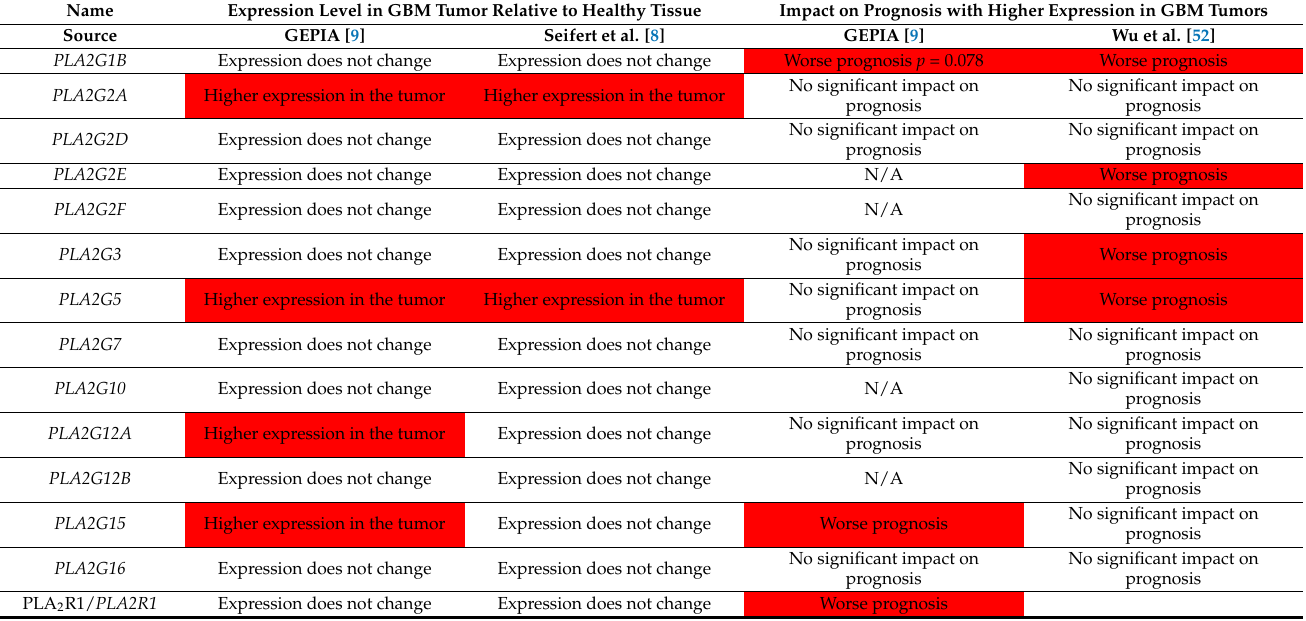
Table 2. Description of sPLA 2 and sPLA 2 receptors in